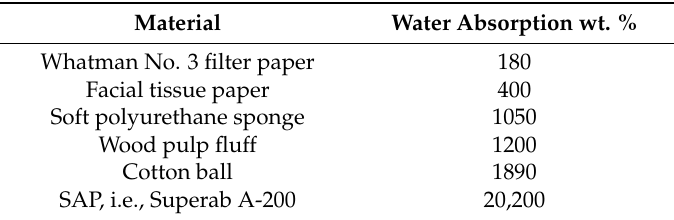
Table 9. Water absorption of different